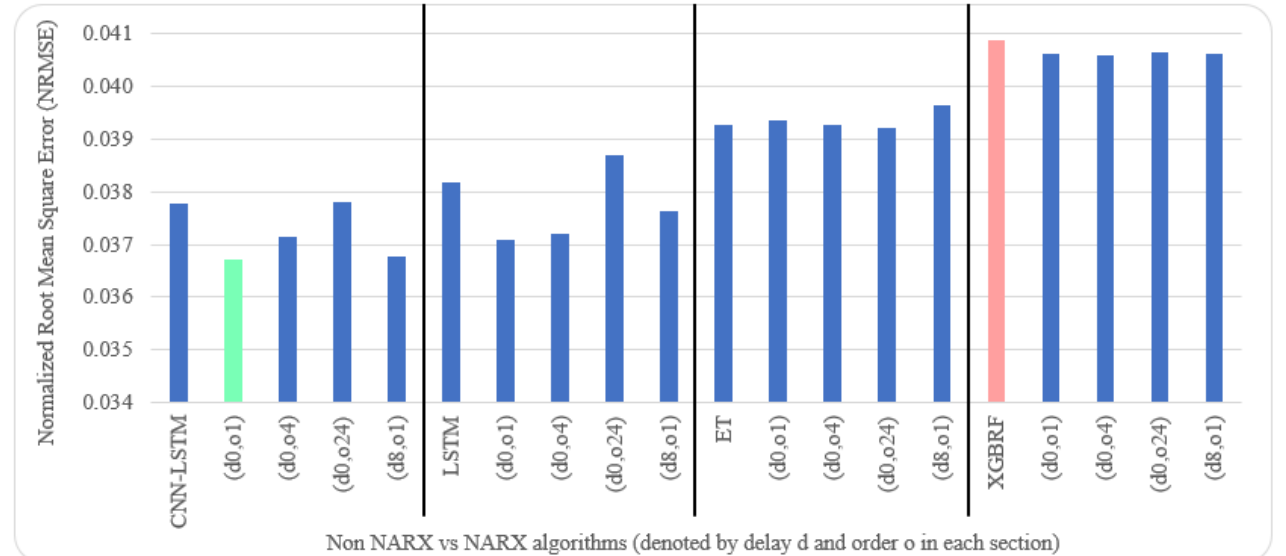
Figure 25. Evaluation results of non-NARX and NARX in terms of normalised root mean square error for the Beijing dataset.